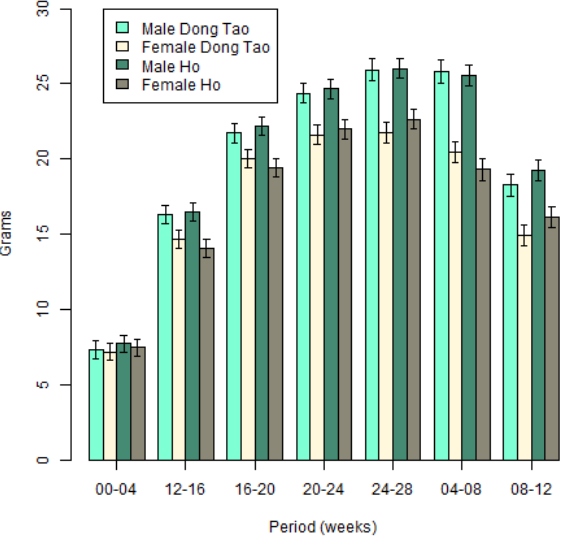
Figure 4. The average daily gains of Ho and Dong Tao chickens.